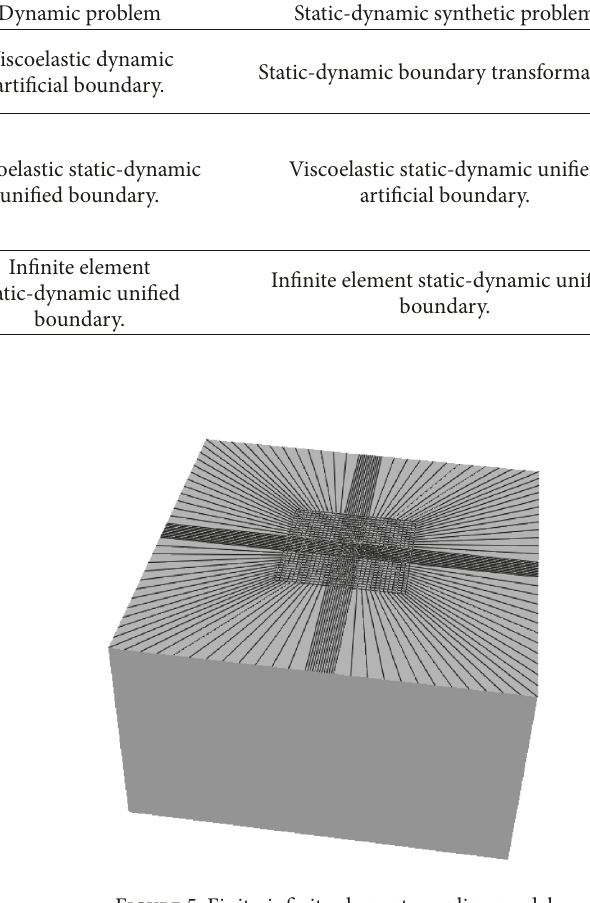
Figure 5: Finite-infinite element coupling